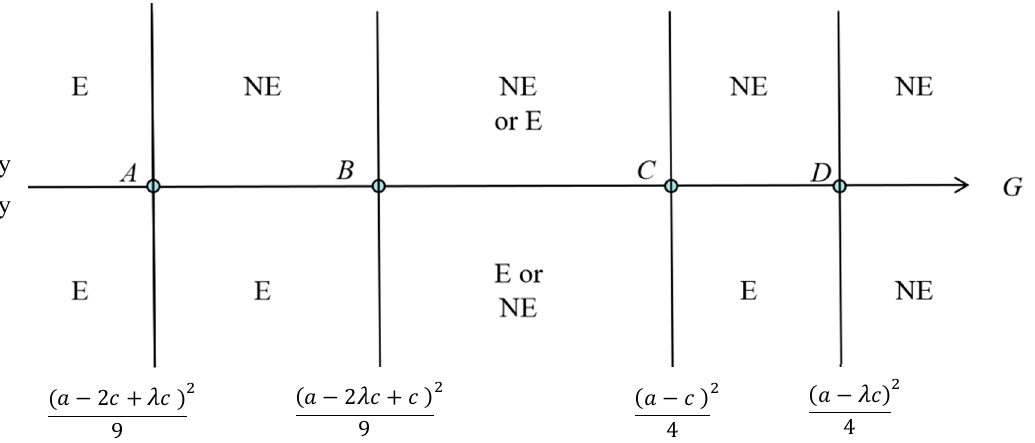
Figure 1. Export decisions when either c < a